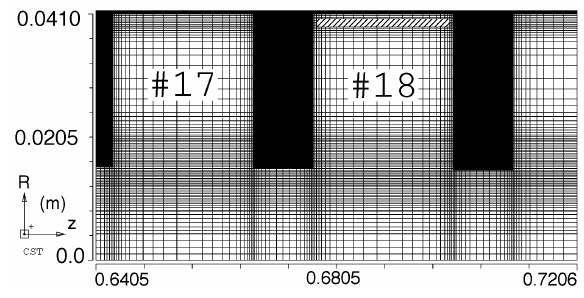
FIG. 13. Three cells out of the 36-cell structure. Cell #18 with the damping material (diagonal hatching).